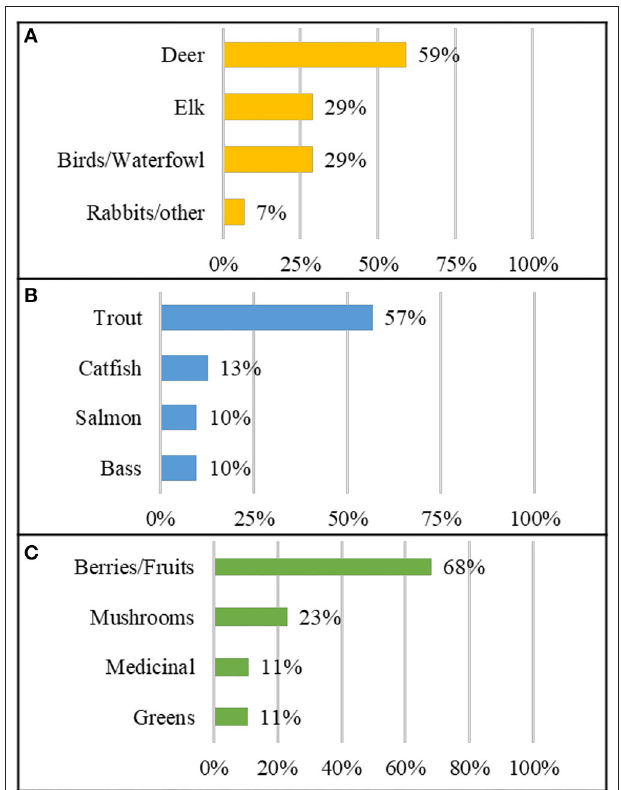
FIGURE 3 | Frequency of wild food consumption for hunting, fishing, and foraging.